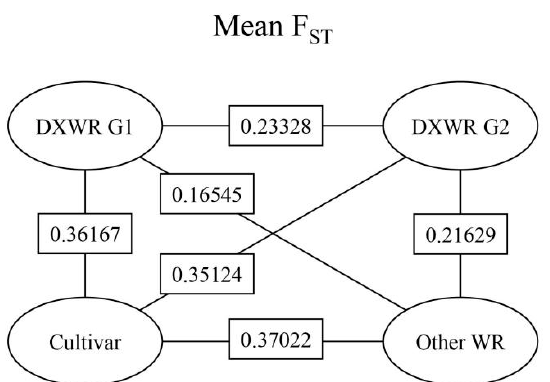
Figure 6. F ST of the two variation types of two subpopulations in DXWR, cultivated rice and other common wild rice. Cultivar: cultivated rice; Other WR: other common wild rice; DXWR G1: G1 subpopulations of DXWR; DXWR G2: G2 subpopulations of DXWR.